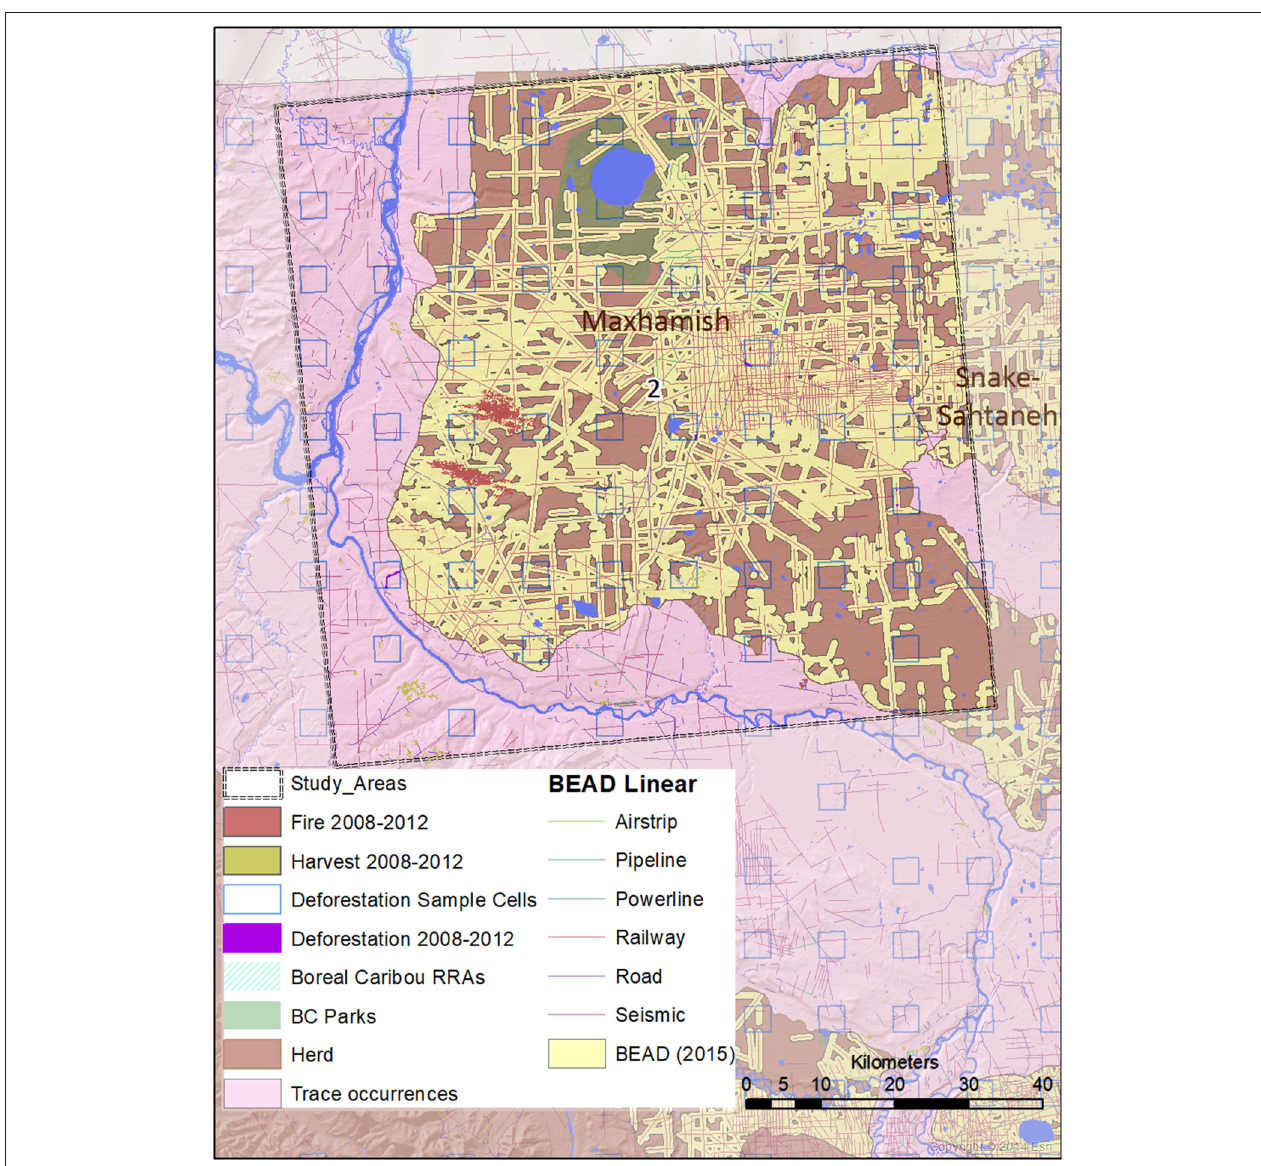
FIGURE 4 | A map of natural and anthropogenic disturbances, deforestation sample cells, and linear features in Study Area 2, associated mostly with the Maxhamish caribou herd. A small portion is also associated with the Snake-Sahtahneh herd. Linear features are those included in the Boreal Ecosystem Anthropogenic Disturbance (BEAD) vector database corresponding to 2008 to 2010 Landsat imagery.